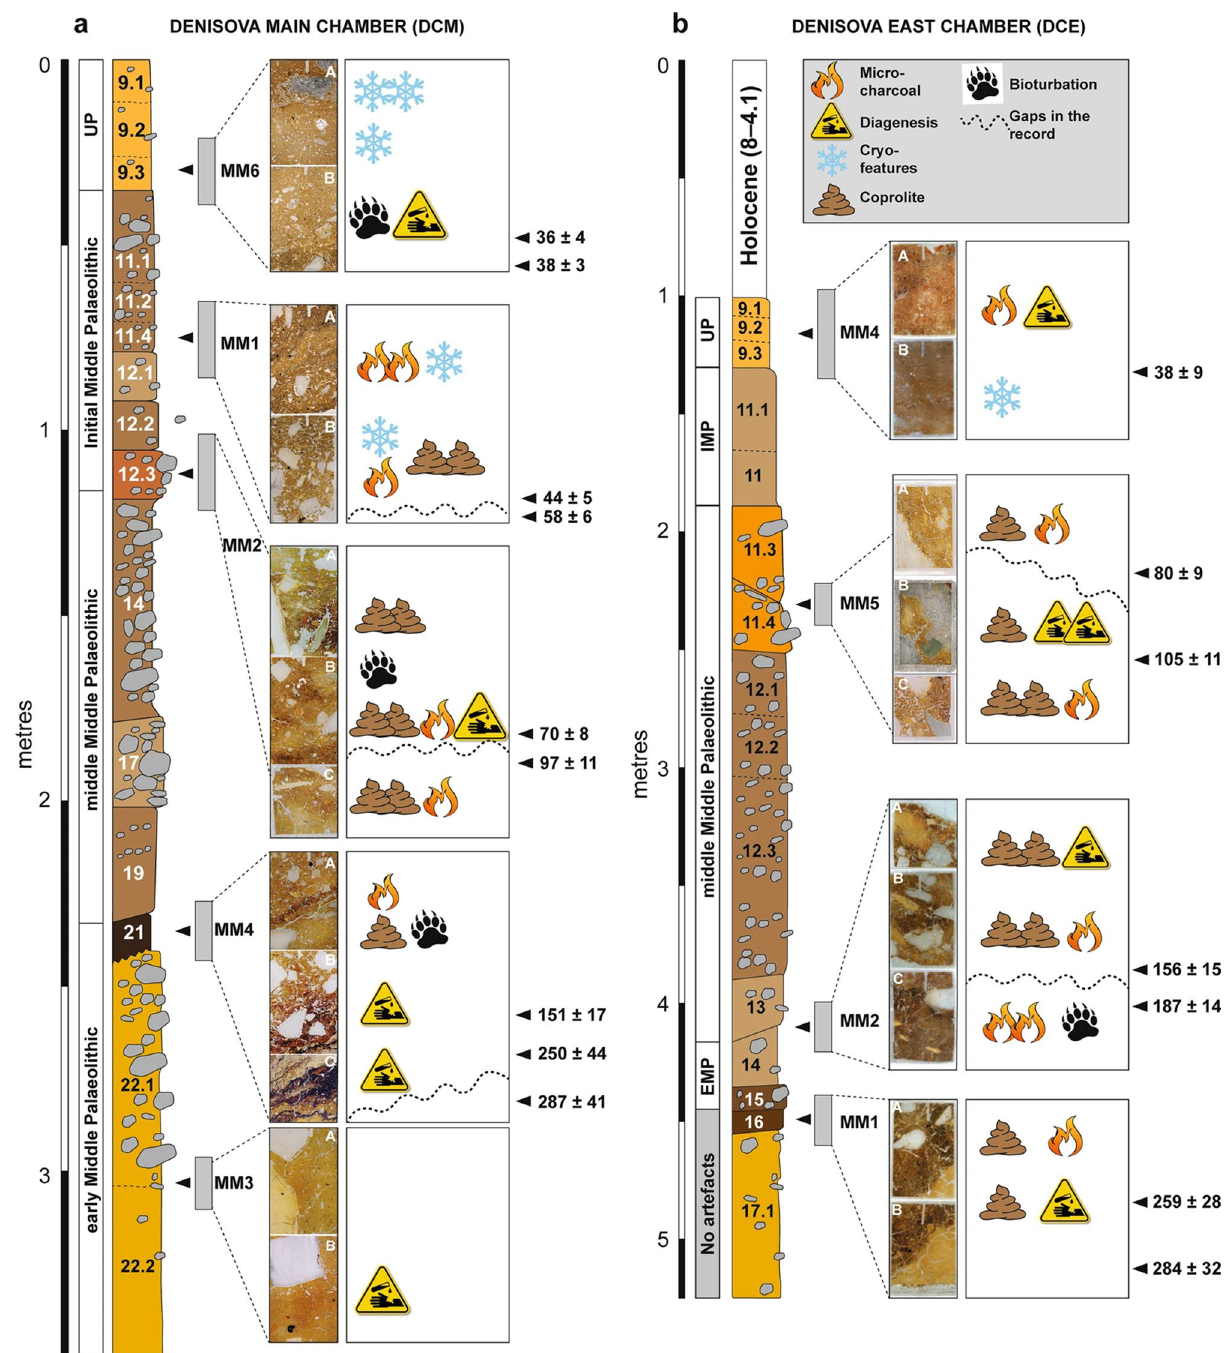
Figure 3. Summary stratigraphic logs of the sequences exposed in ( a ) DCM and ( b ) DCE, showing the locations of the micromorphological samples and key microstratigraphic features. To the right of each log, optical ages (in ka, with uncertainties at 95.4% probability) are shown for the major boundaries between lithological units in the thin sections, together with the associated archaeological phases (from ref. 9